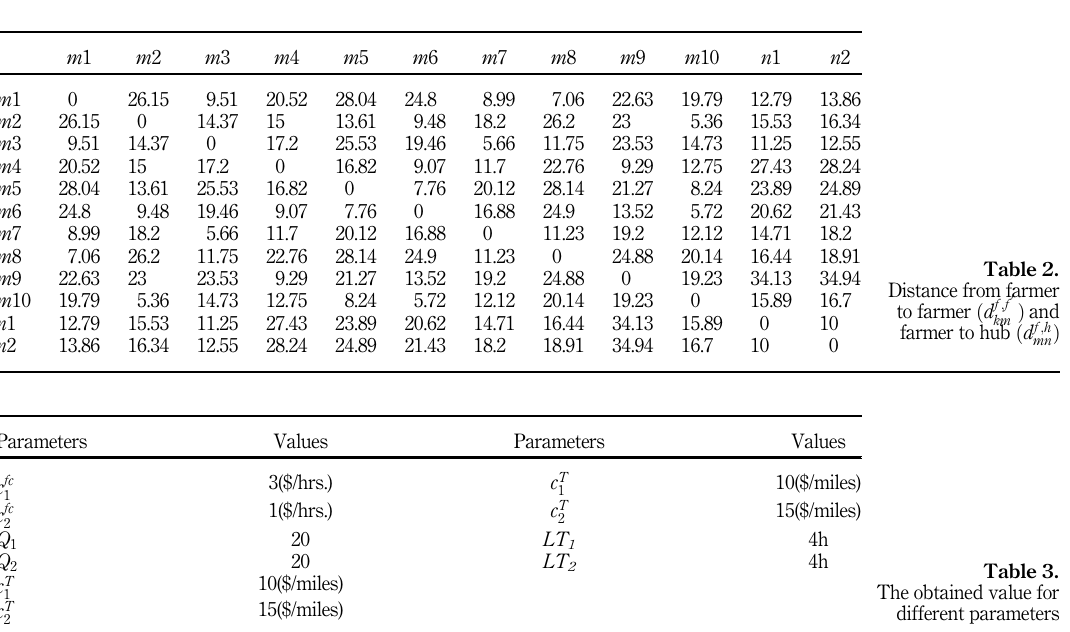
Table 3. The obtained value for different parameters